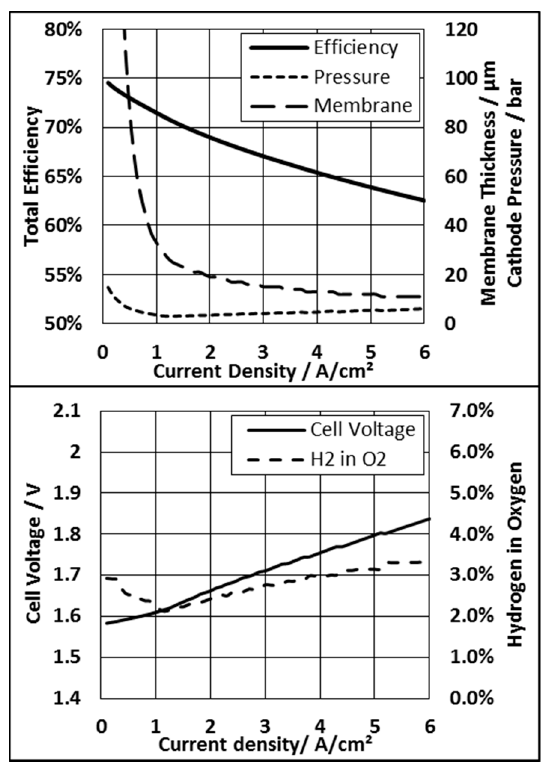
Figure 4. Maximum total system efficiency of the polymer electrolyte membrane (PEM) electrolyzer (Equation (7)) as a function of current density determined by evaluating the optimal membrane thickness and optimal cathode pressure when no restrictions are assumed.